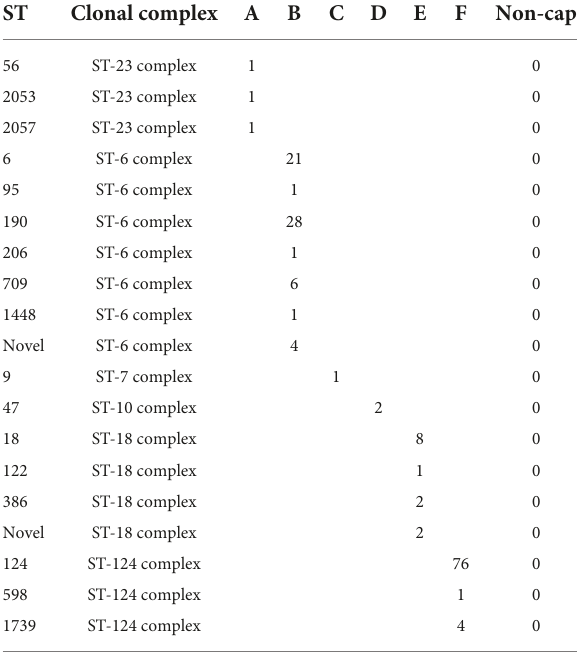
TABLE 4 Sequence type and clonal complex found among the Haemophilus influenzae isolates with a